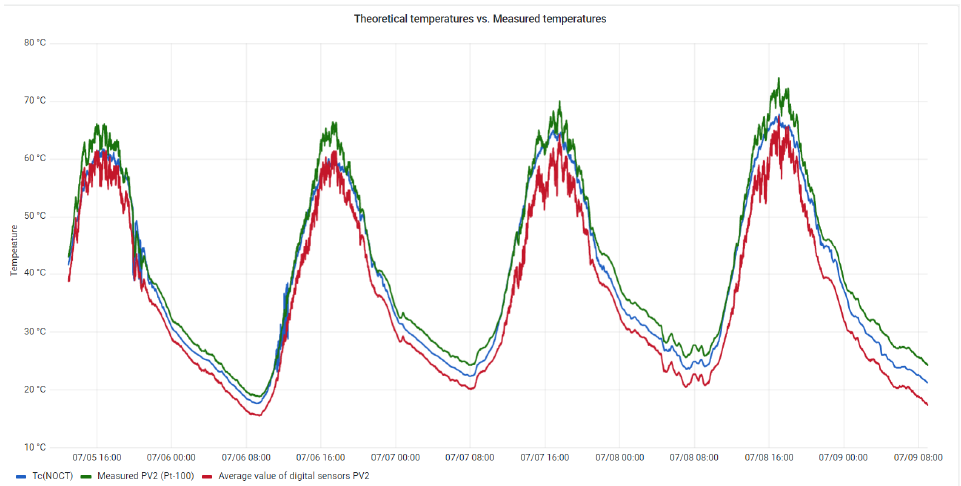
Figure 3. Operating temperature of second panel.